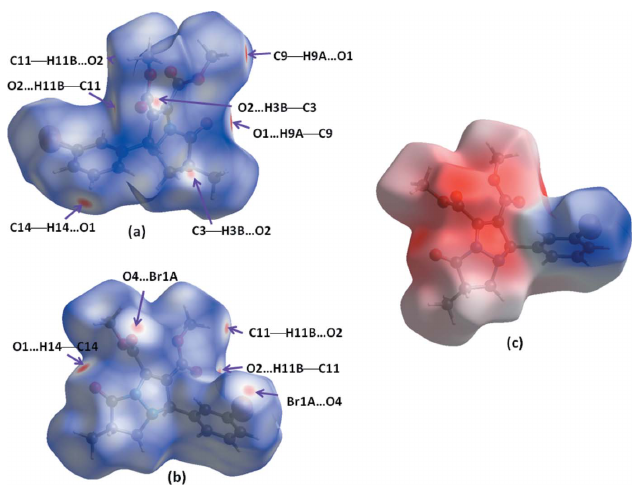
Figure 3 Hirshfeld surfaces of the title compound mapped over ( a ) and ( b ) d norm to visualize the intermolecular C—H (cid:3)(cid:3)(cid:3) O and Br (cid:3)(cid:3)(cid:3) O contacts and ( c ) electrostatic potential energy using the STO-3 G basis set at the Hartree– Fock